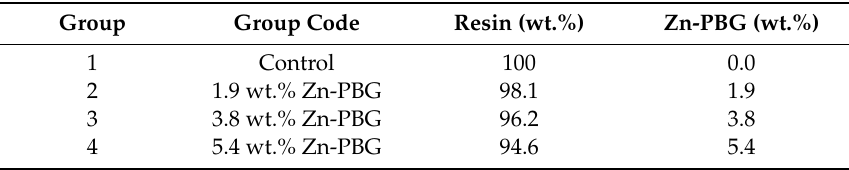
Table 1. Control and experimental groups in the